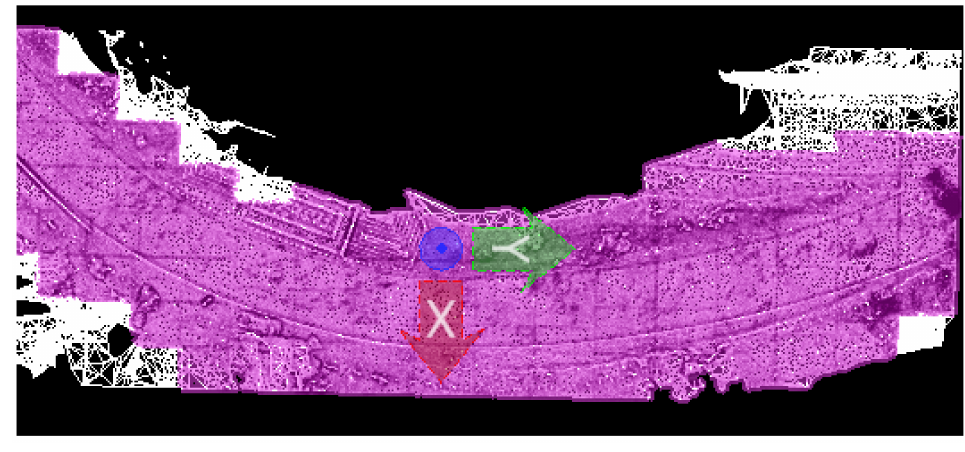
Figure 11. Surface mapping.